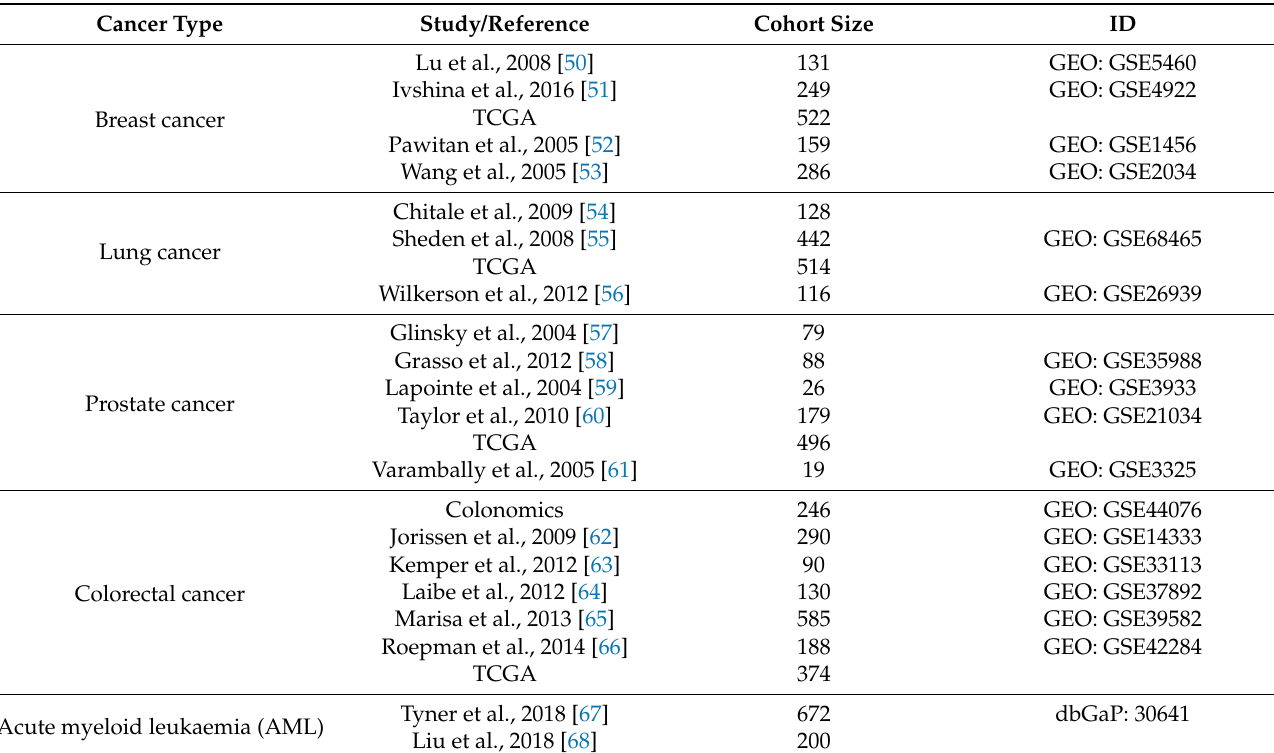
Table 3. List of datasets used in our in silico analysis of the correlation between the expression of XPO1 and the expression of TARGET genes. Data for solid tumor cohorts are pre-loaded in the CANCERTOOL webtool (http://genomics.cicbiogune.es/CANCERTOOL/citeUs.html, accessed on 11 January 2019). AML data from Liu et al. were retrieved at